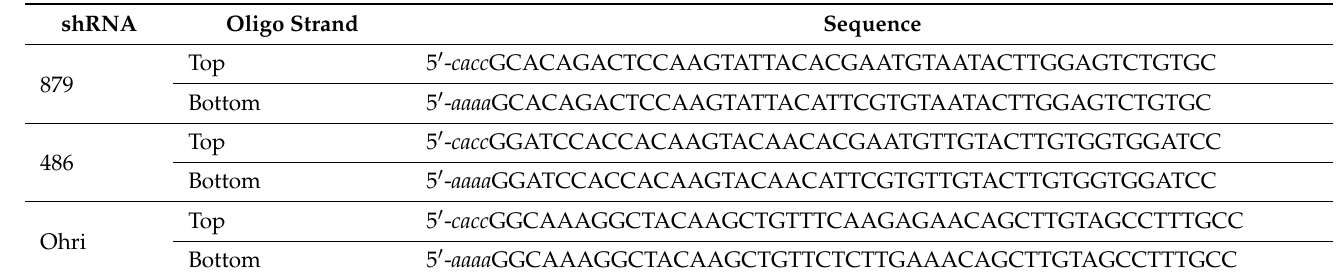
Table 1. Oligonucleotide sequences of both top and bottom strands of shRNA 879, 486 and Ohri are shown. Nucleotides for the directional cloning of the double strand oligonucleotides into the pENTR™/H1/TO vector are shown in